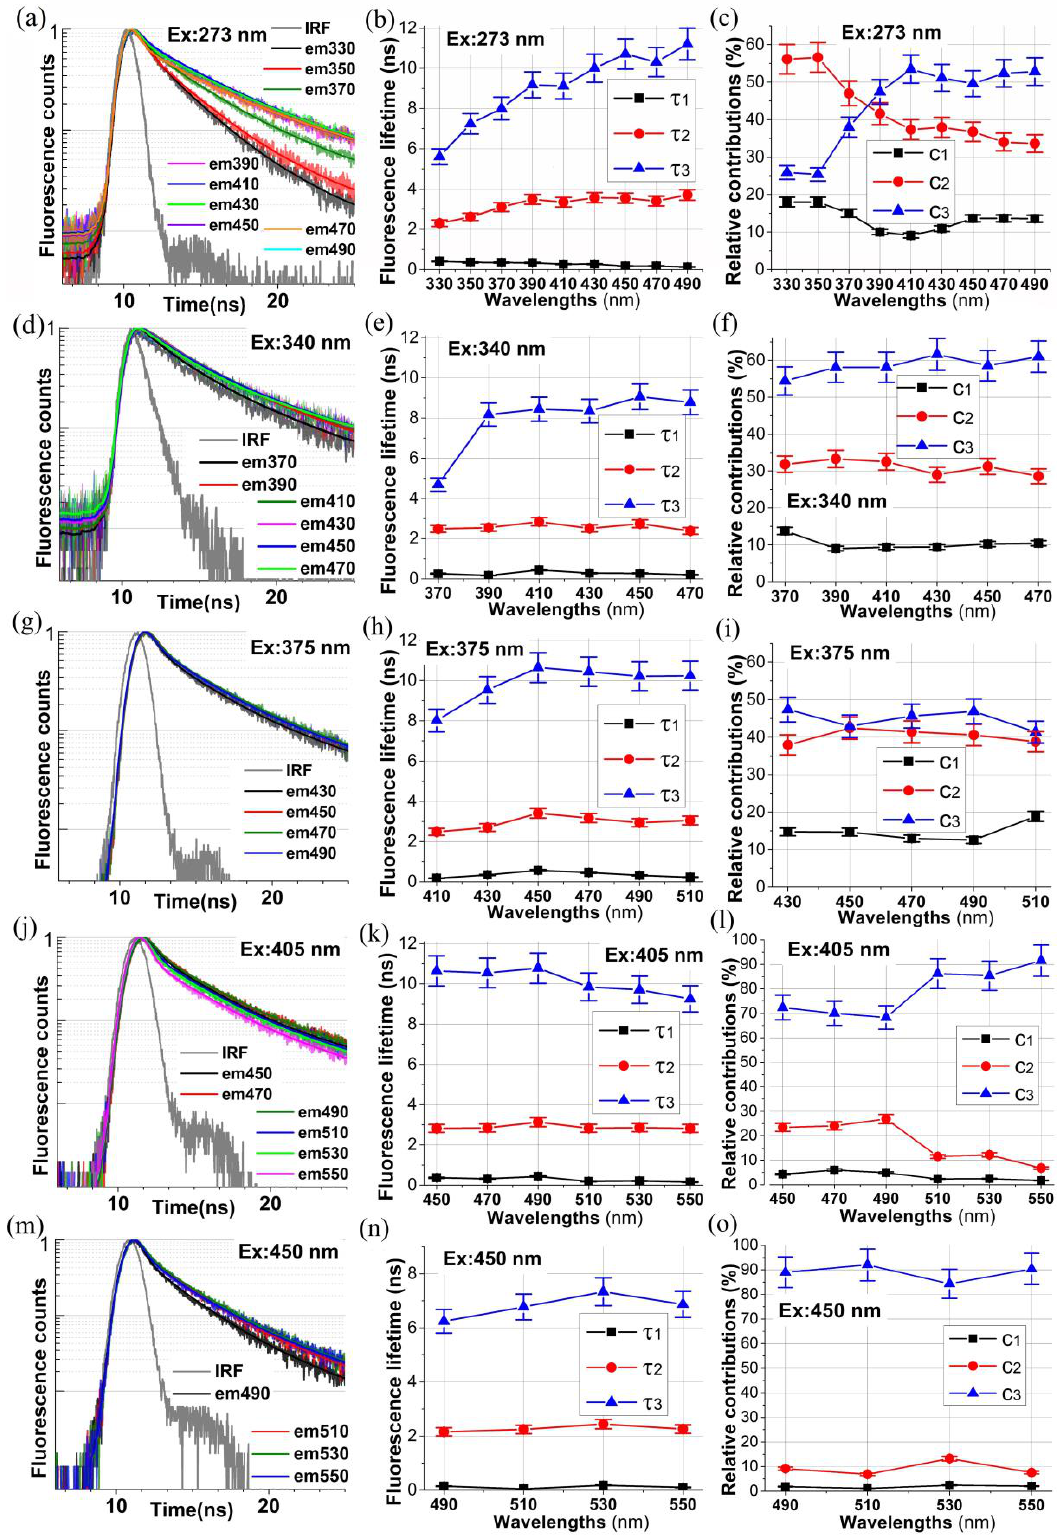
Figure 2. Autofluorescence decays of collagen (panels ( a , d , g , j , m )), and the recovered decay param- eters: decay times (panels ( b , e , h , k , n )) and amplitudes ( c , f , i , l , o ) (see text).